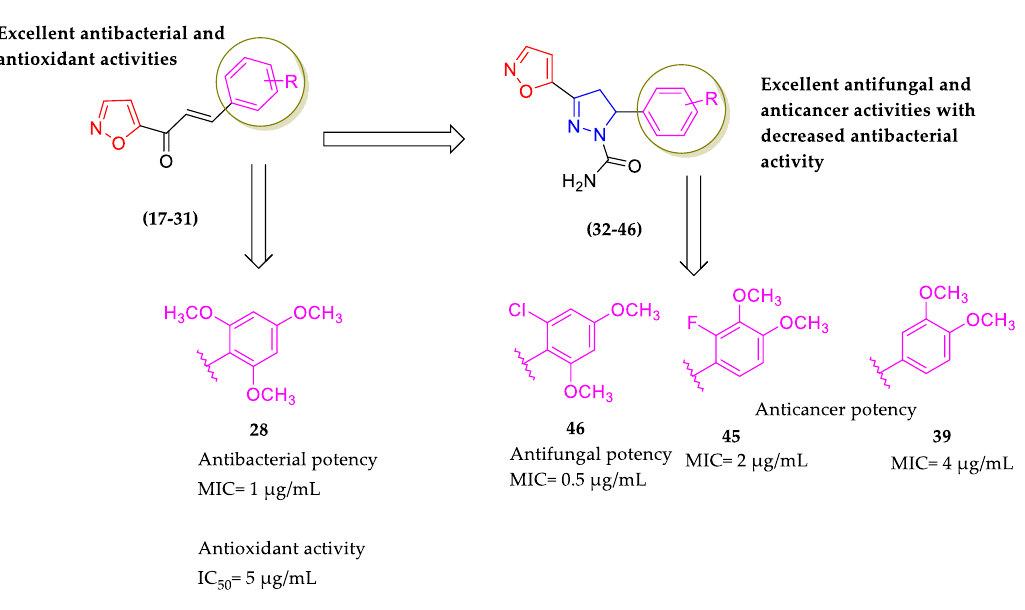
Figure 3. Summarization of the antibacterial, antifungal, antioxidant, and cytotoxic activities of chalcones ( 17 – 31 ) and dihydropyrazoles ( 32 – 46 ).